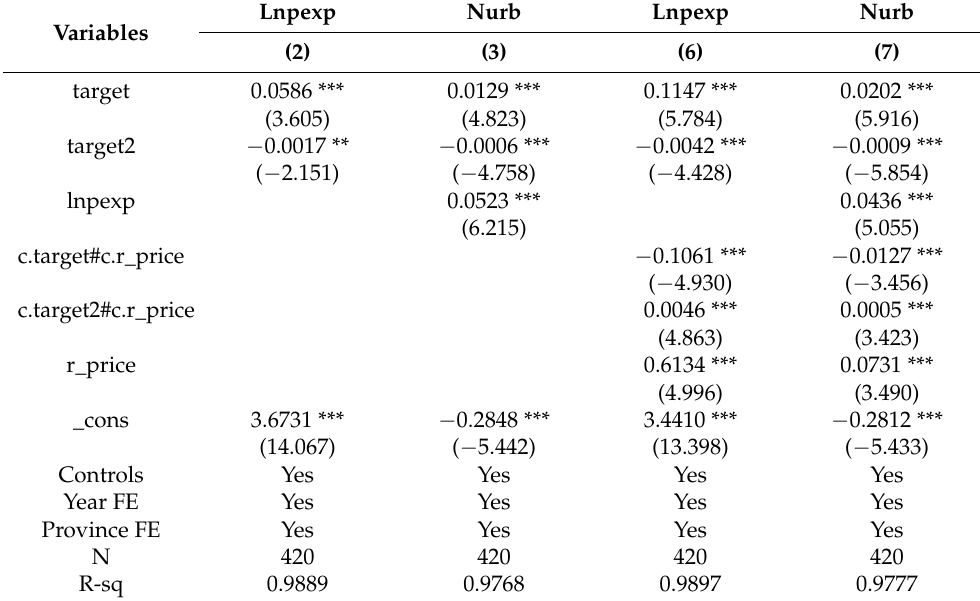
Table 4. Mediating and moderating